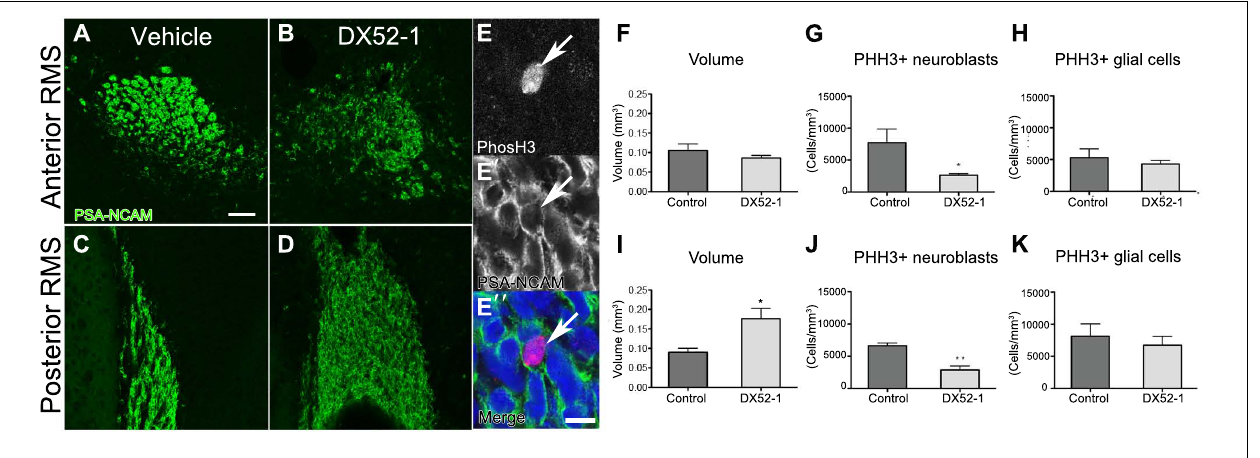
(F) There was no difference in the volume of the anterior RMS of vehicle and DX52-1 treated animals. (I) The volume of the posterior RMS was increased after infusion of DX52-1. (G, J) The number of PHH3 and PSA-NCAM double positive cells in the anterior (G) and posterior (J) RMS was decreased after 4 days of DX52-1 intracerebroventricular infusion. However, there was no difference in the number of PHH3 positive/PSA-NCAM negative cells in the anterior (H) or posterior RMS (K) (* p < 0.05, ** p < 0.01). Scale bar in (A) = 50 μ m, scale bar in (E´´) = 10 μ